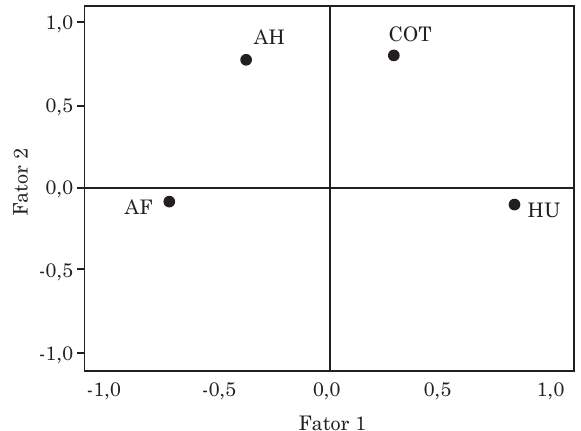
Figura 2. Comportamento das variáveis na análise de componentes principais: carbono orgânico total (COT), ácidos húmicos (AH), ácidos fúlvicos (AF) e humina